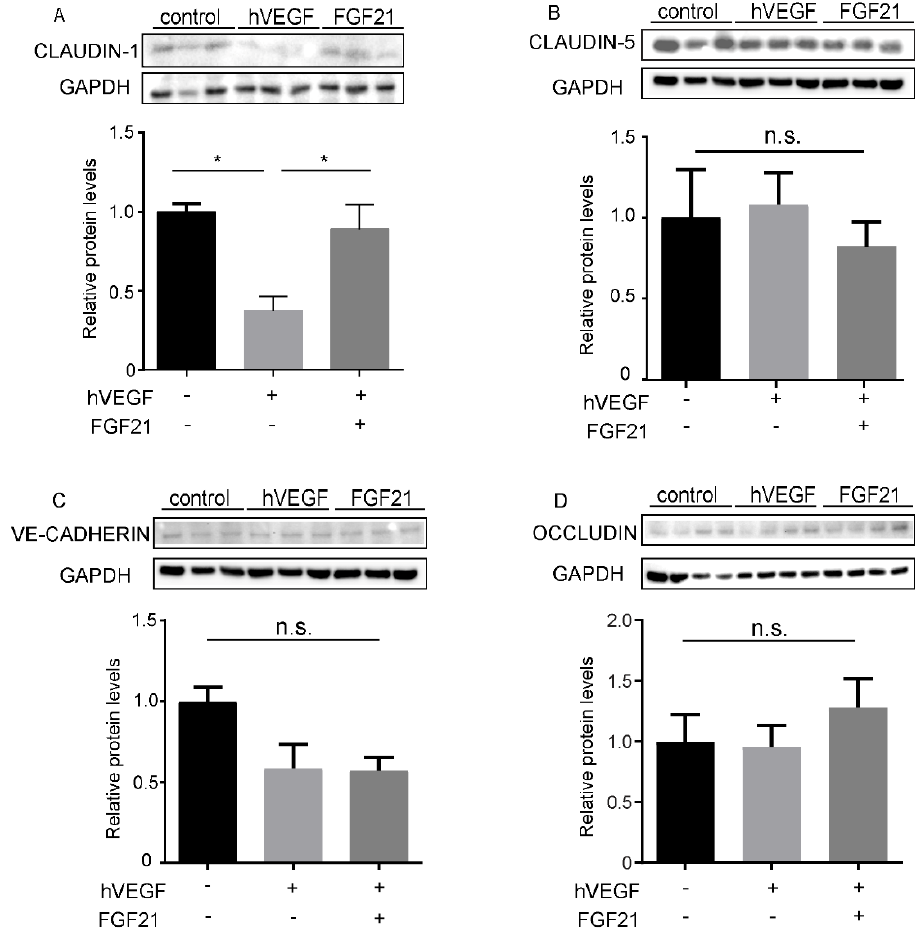
Figure 4. FGF21 preserves Claudin-1 expression in HRMECs. ( A ) A representative image of Claudin-1 Western blotting. hVEGF treatment decreased levels of Claudin-1 protein ( p = 0.048), while FGF21 preserved Claudin-1 protein expression levels following hVEGF treatment ( p = 0.035). ( B ) A